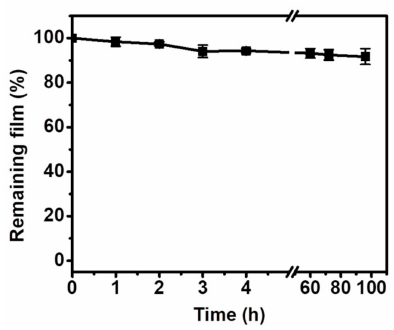
Figure 2. Stability of the TA coating on the quartz in the PBS containing 4 mg mL − 1 of bovine serum albumin